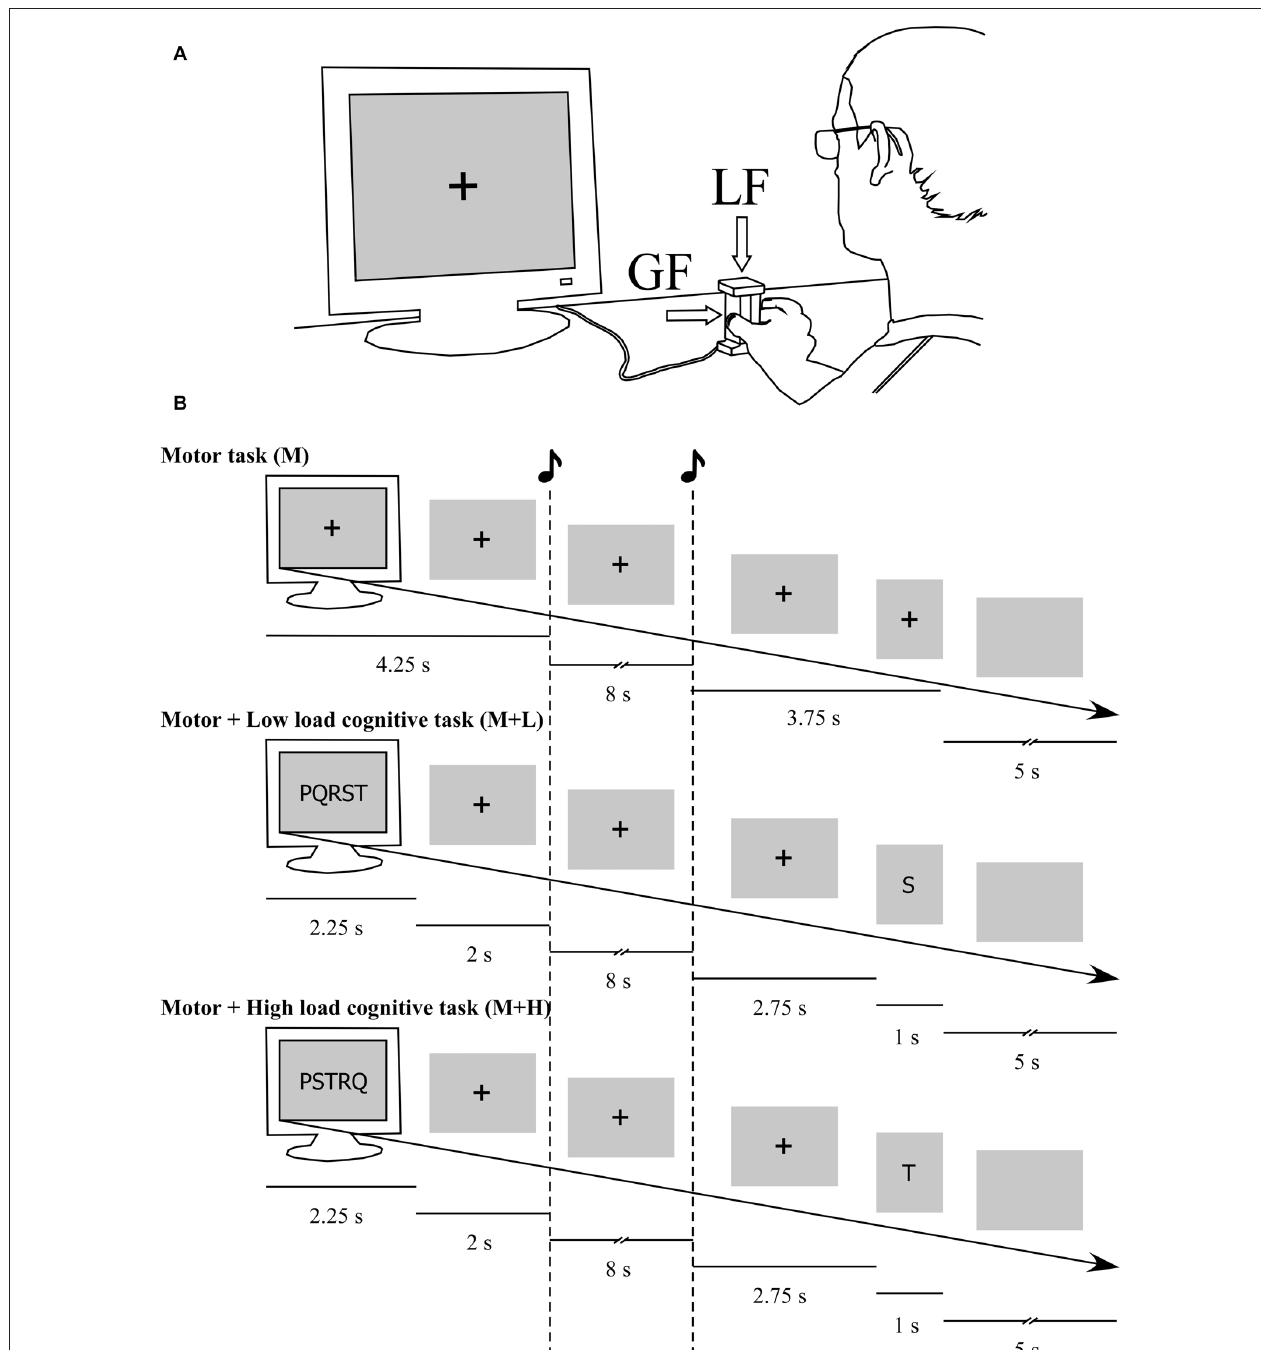
FIGURE 1 | Experimental procedures and time course of trials in the different conditions. (A) Participants were seated in front of a computer display and grasped the apparatus between the thumb and the index. The device was equipped with strain gauges which allowed measuring the grip force (GF) and load force (LF) developed during the experiment. They had to keep their eyes on the fixation cross when no other stimulus was displayed. (B) In the Motor condition (M), an auditory tone prompted the participant to grip, lift and hold the object approximately 5 cm above the table. After 8 s, a second auditory tone prompted the participant to put down the object on the table and to reposition their hand at rest next to the object. In the Motor + Cognitive conditions, a list of letters appeared at trial onset. Participants were requested to remember this list of letters, whose length was adapted to their individual memory span. The list was in alphabetical order in the Motor + Low-load cognitive condition (M + L) and in randomized order in the Motor + High-load cognitive condition (M + H). Participants performed the grip-lift-hold task while maintaining the list of letters in working memory. After the motor task, a random letter from the initial memory set reappeared, and participants were instructed to report verbally which letter of the memory set was presented after that